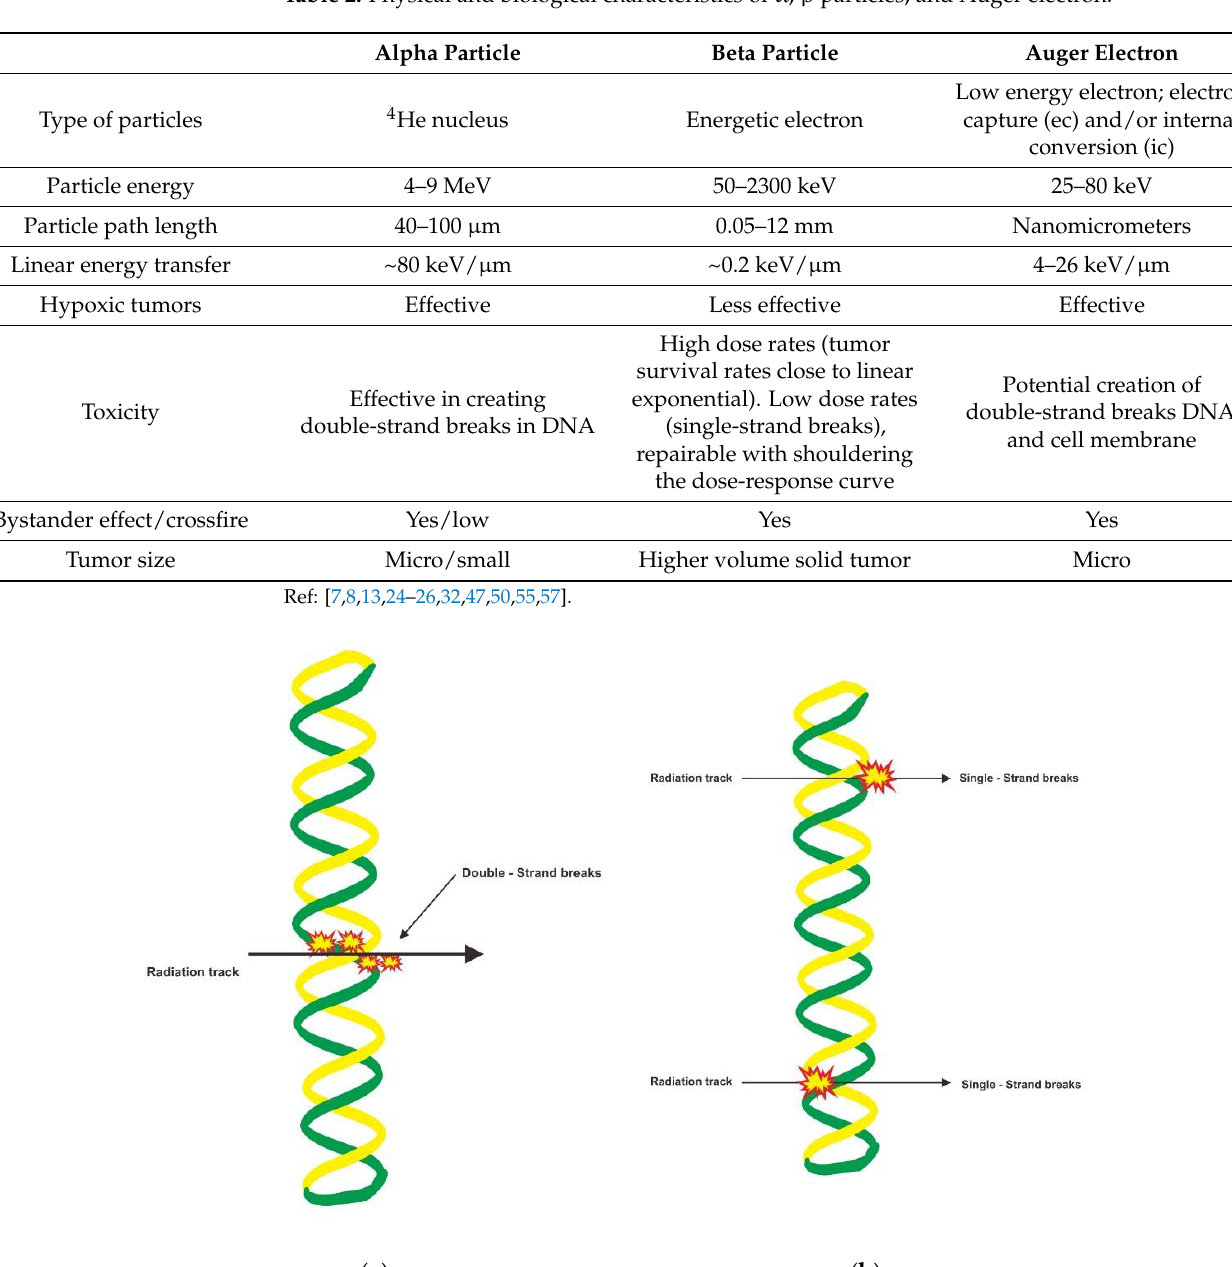
Table 2. Physical and biological characteristics of α, β particles, and Auger electron.